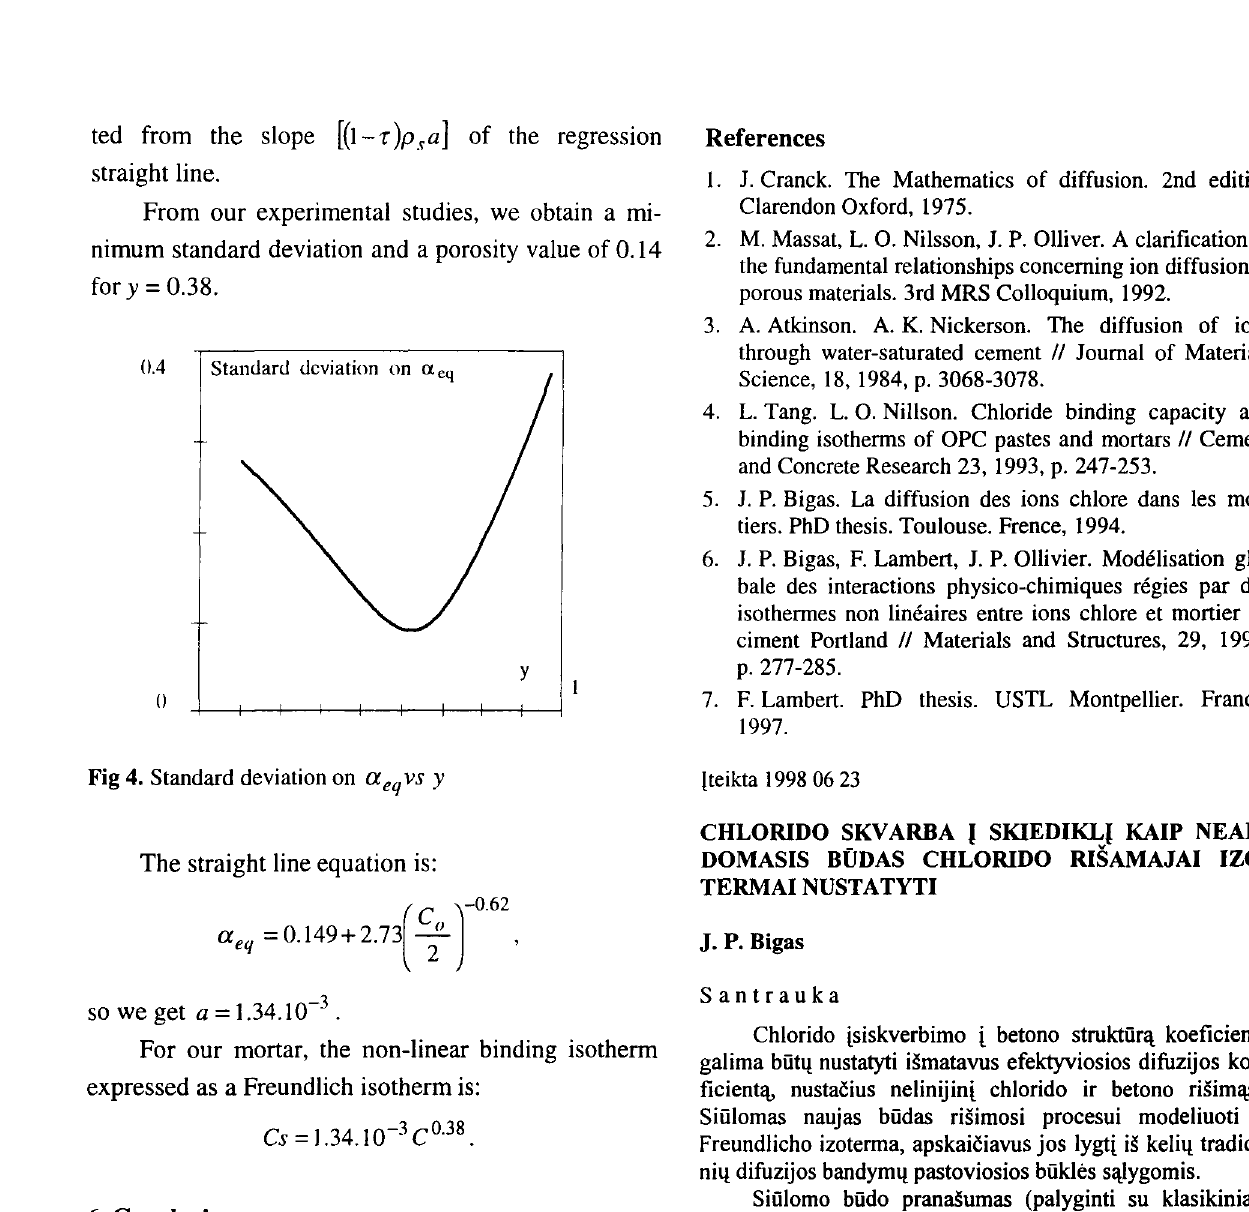
Fig 4. Standard deviation on aeq vs y